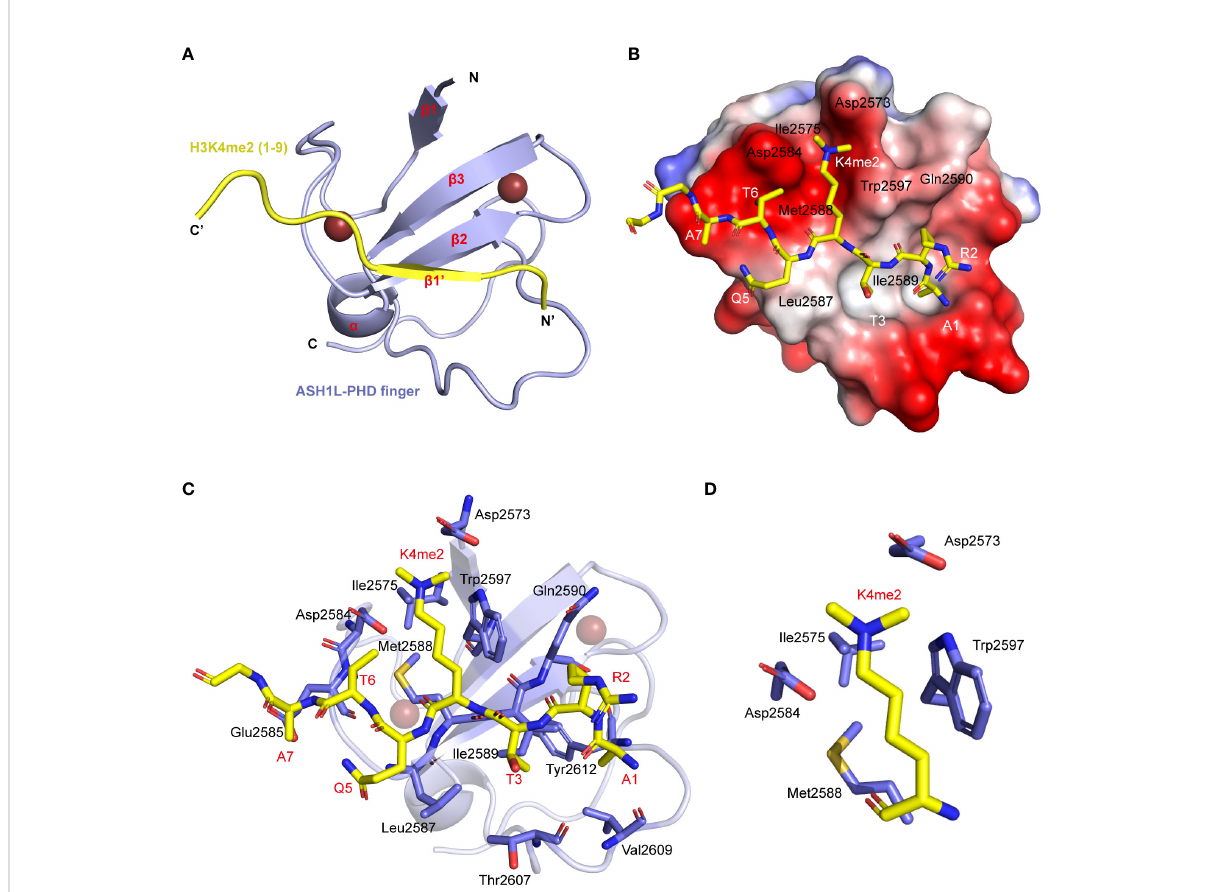
FIGURE 2 Structure of ASH1L PHD fi nger binding with the H3 (1 – 15) K4me2 peptide. (A) Cartoon representation of the NMR structure of the ASH1L PHD fi nger (light blue)/H3K4me2 peptide (yellow). (B) Electrostatic potential surface representation of the ASH1L PHD fi nger binding with H3K4me2 peptide in stick depiction (color-coded by atom type). The amino acid around the K4 residue and in the b 2 strand are labeled. (C) The key residues involved in the intermolecular interactions at the protein/peptide interface are labeled. These side chains are color-coded by the atom type and showed in the stick model. (D) The key side chains of binding groove around K4me2 are picked